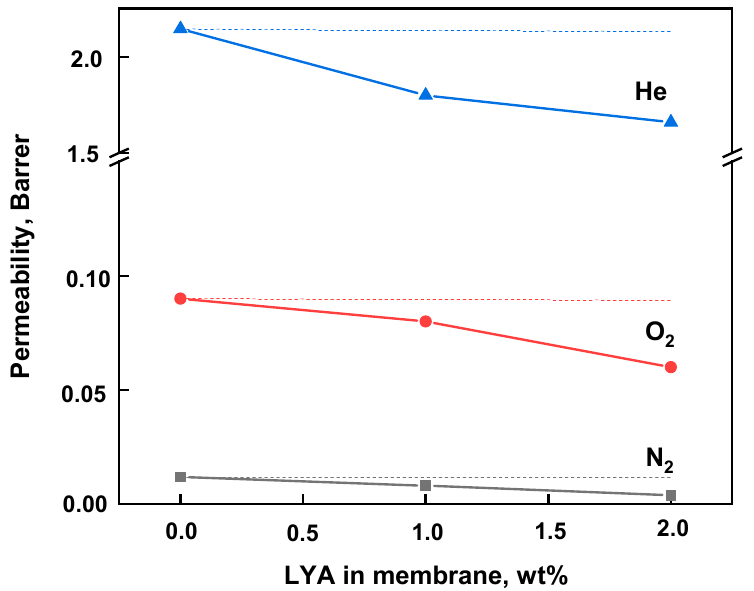
Figure 13. Dependence of gas permeability on the LYA content in the membrane at 20 ◦ C. Dotted lines represent the values of gas permeability calculated according to the Maxwell model [44].